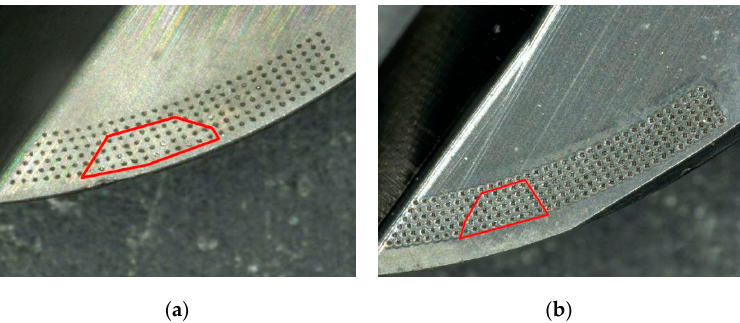
Figure 13. Wear areas of micro-textured tools. ( a ) Wear area of micro-textured tool with blunt tool edge. ( b ) Wear area of micro-textured tool with chamfer tool edge.